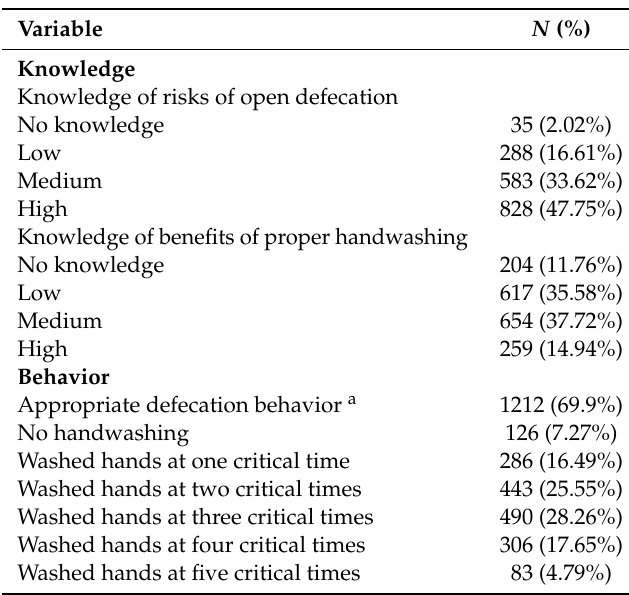
Table 3. Knowledge and behavior